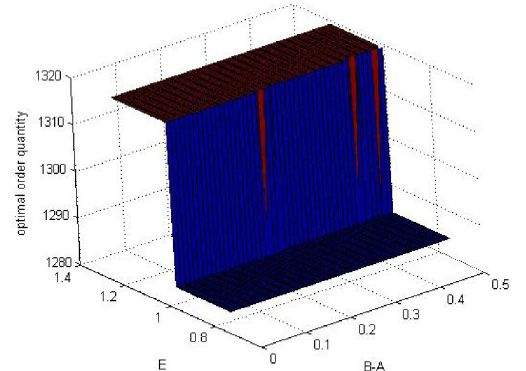
Figure 1. Optimal order quantity with buy-back contract (settle the buy-back payment in the currency of country 1)